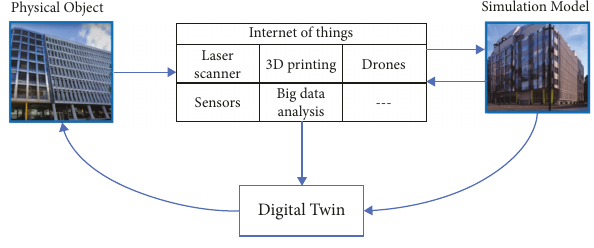
Figure 1: Digital Twin technology